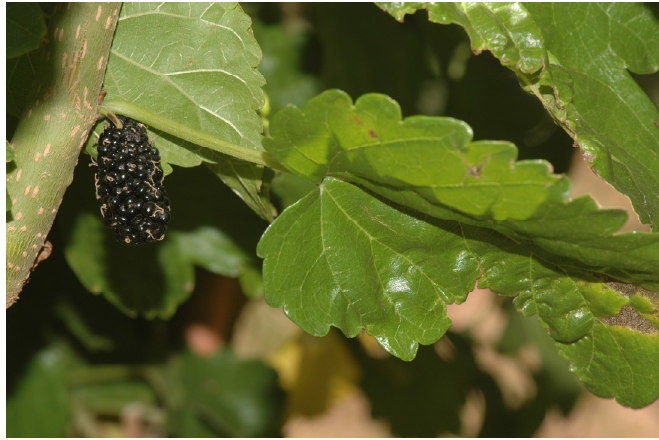
Figure 1. Fruit and leaves of Morus nigra L.